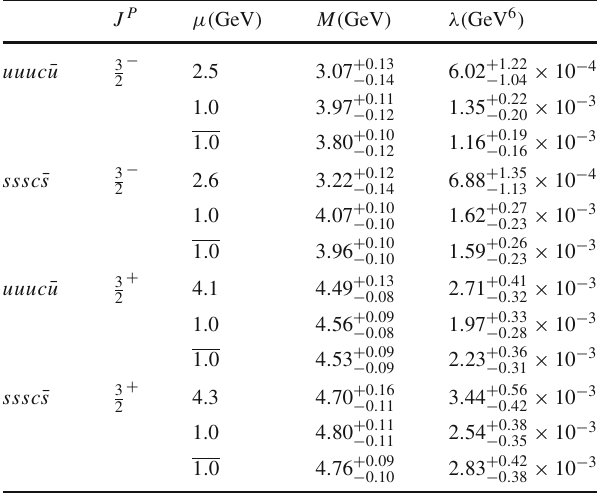
Table 2 The predicted masses and pole residues of the charmed pen- taquark states